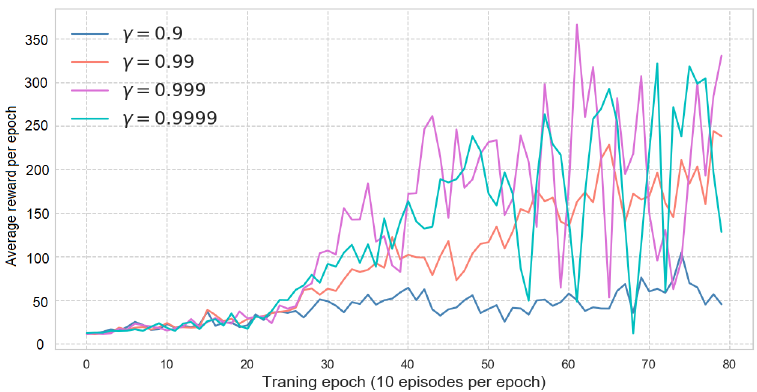
Figure 21. DDQN hyper-parameter tuning for discount factor, γ .